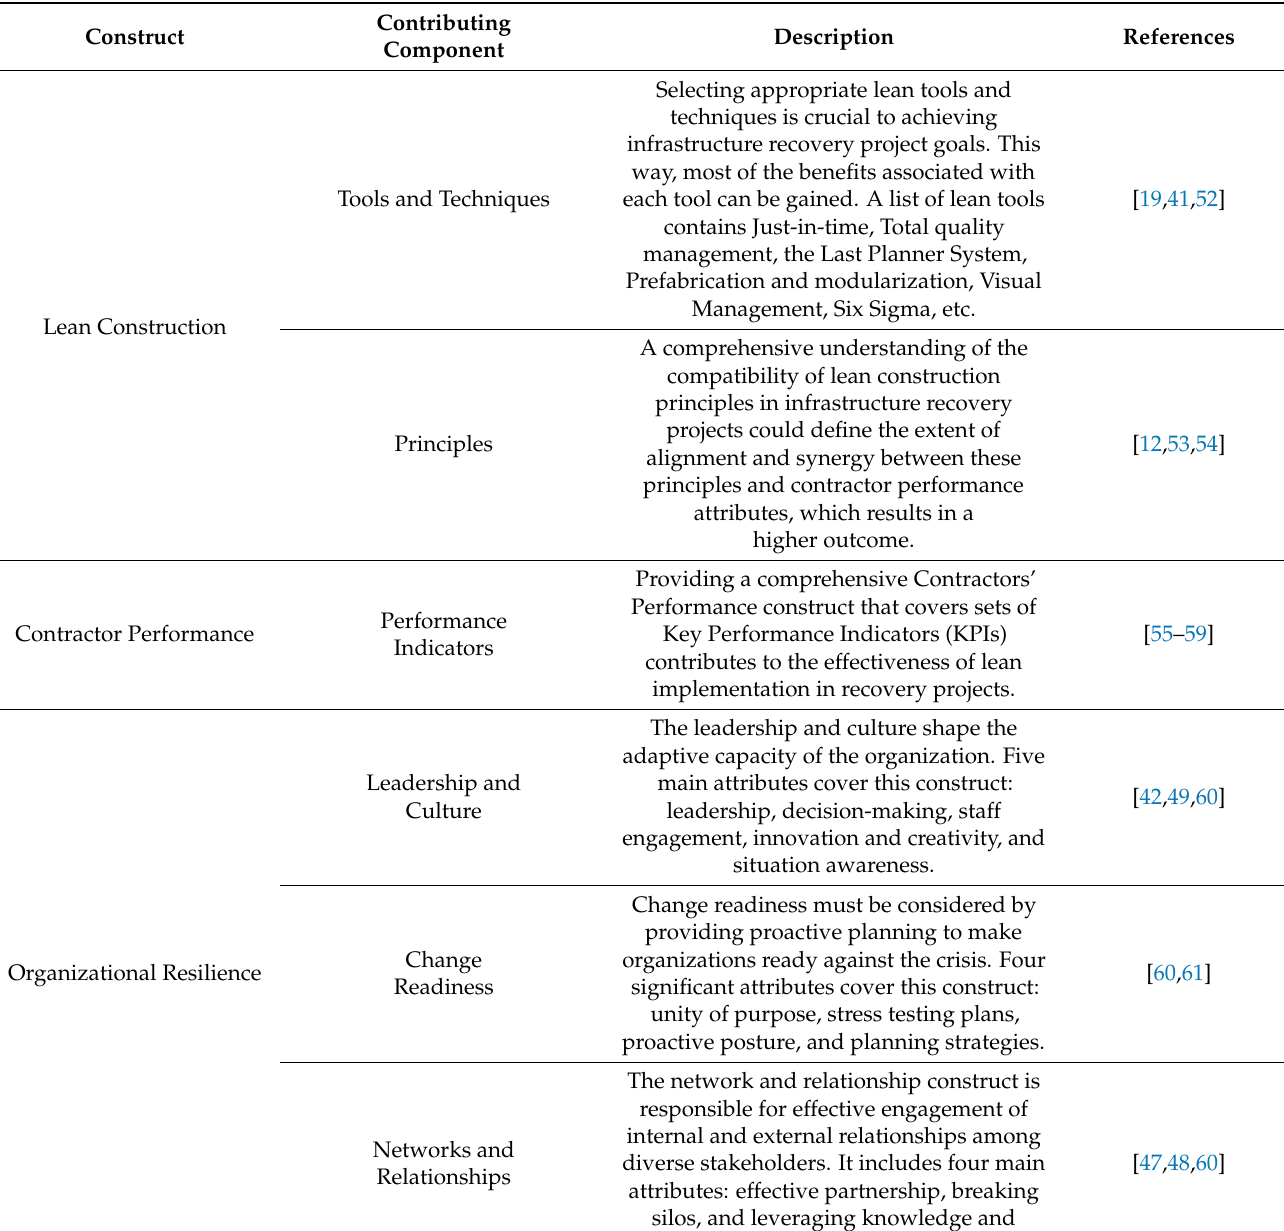
Table 2. Contributing components to effective implementation of lean construction in infrastructure recovery